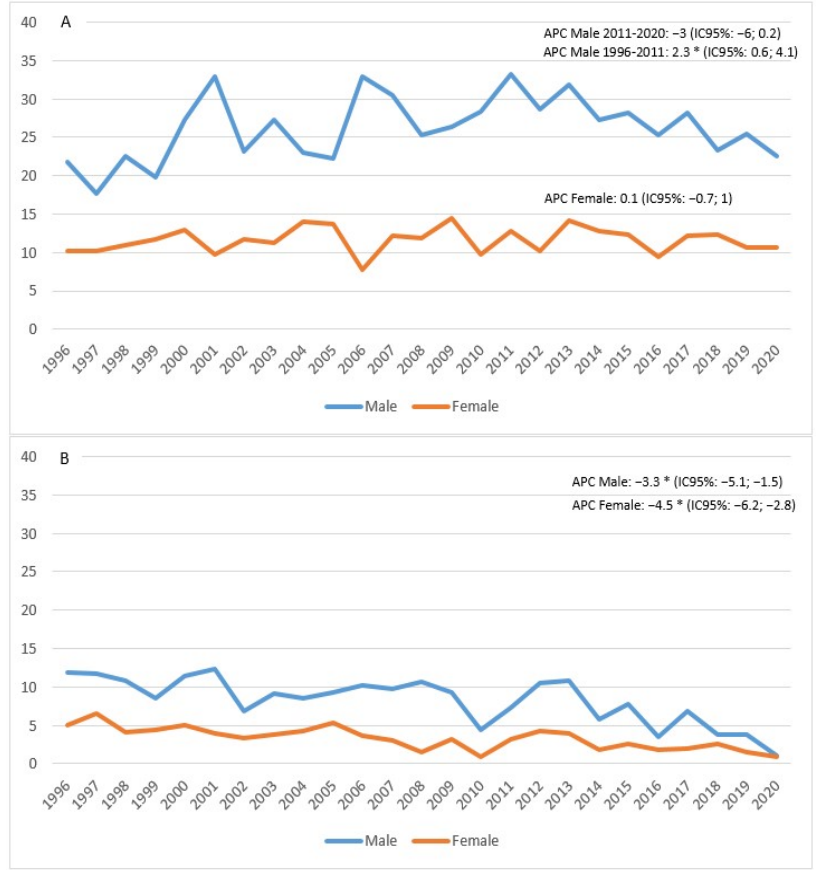
Figure 3. Age ‐ standardized incidence ( A ) and mortality ( B ) rates per 100,000 p ‐ y in the Province of Figure 3. Age-standardized incidence ( A ) and mortality ( B ) rates per 100,000 p-y in the Province of Reggio Emilia in the period 1996–2020. Reggio Emilia in the period